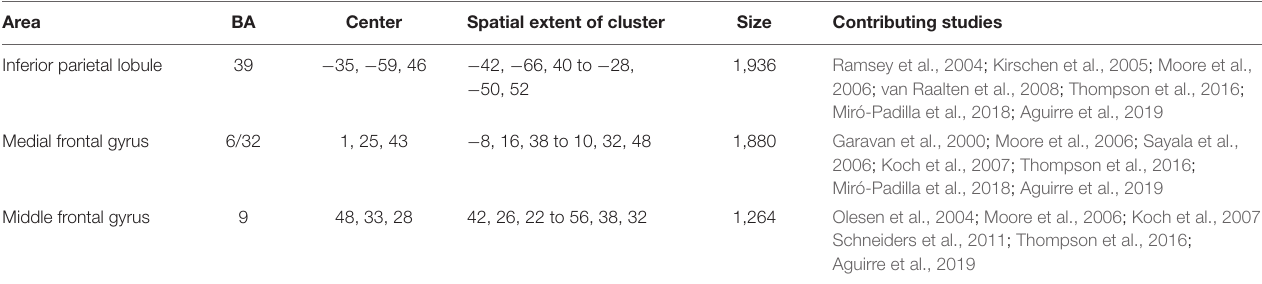
FIGURE 2 | The neural correlates of working memory training. Across all studies, working memory training engaged clusters encompassing the left inferior parietal lobule (BA 40), right middle frontal gyrus (BA 9), and medial frontal gyrus bordering on the cingulate gyrus (BA 6/32) (depicted in red). In turn, working memory training was associated with decreases in brain activation in clusters encompassing the bilateral inferior parietal lobule (BA 39/40), middle (BA 9), and superior (BA 6) frontal gyrus, and medial frontal gyrus bordering on the cingulate gyrus (BA 8/32) (depicted in blue) (see text, Tables 2 , 3 ). The transparencies of the activations are set to 50% to reveal three areas of overlap in the left inferior parietal lobule (BA 40), right middle frontal gyrus (BA 9), and medial frontal gyrus bordering on the cingulate gyrus (BA 6/32). IPL, inferior parietal lobule; MFG, middle frontal gyrus; SFG, superior frontal gyrus; MEFG, medial frontal gyrus. TABLE 2 | The neural correlates of working memory training across all